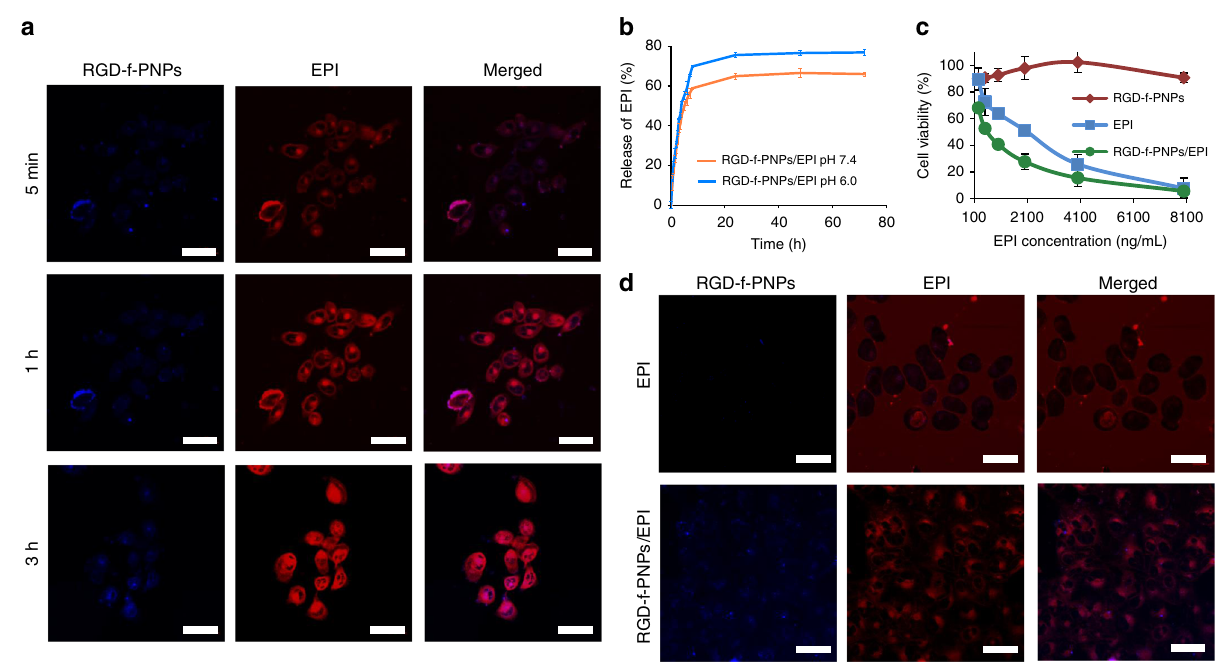
Fig. 4 In vitro drug release monitoring and enhanced anti-tumor ef fi cacy. a Confocal fl uorescence images of KYSE-30 cells after being incubated with the RGD-f-PNPs/EPI conjugates for 5 min, 1 h, and 3 h. With a prolonged incubation time, more EPI was released. Consequently, the fl uorescence intensity of both the RGD-f-PNPs and EPI gradually increased. The data suggest that it is possible to visualize the drug-releasing process using RGD-f-PNPs as a nanocarrier. Scale bar: 40 μ m. b The EPI release kinetics from the RGD-f-PNPs at room temperature in PBS at pH 7.4 and 6 was measured and plotted with respect to the change of the absorbance intensity at 480 nm. The results indicated that more EPI was released in an acidic environment. Error bars represent s.d. ( n = 3). c Viability of KYSE-30 cells after being treated with RGD-f-PNPs alone, EPI alone, and RGD-f-PNPs/EPI at different concentrations. Without EPI loading, the RGD-f-PNPs indicate low cytotoxicity. The cytotoxicity of RGD-f-PNPs/EPI was signi fi cantly higher than EPI alone in KYSE-30 cells, in which RGD-f-PNPs had selective targeting through RGD-integrin α v β 3 subunit binding. Especially at lower drug dose, RGD-f-PNPs/EPI indicated more signi fi cantly enhanced anti-tumor ef fi ciency compared to EPI alone. Error bars represent s.d. ( n = 3). d Confocal fl uorescence images of KYSE-30 cells incubated with RGD-f-PNPs/EPI and EPI alone. A much brighter intracellular fl uorescence of EPI was observed in cells incubated with RGD-f-PNPs/EPI vs. cells incubated with EPI only, indicating that the RGD-f-PNPs could facilitate the cellular uptake and intracellular accumulation of EPI into EC cells. In addition, a different internalization pattern was observed when treated with EPI alone compared to EPI-loaded RGD-f-PNPs. Scale bar: 40 μ